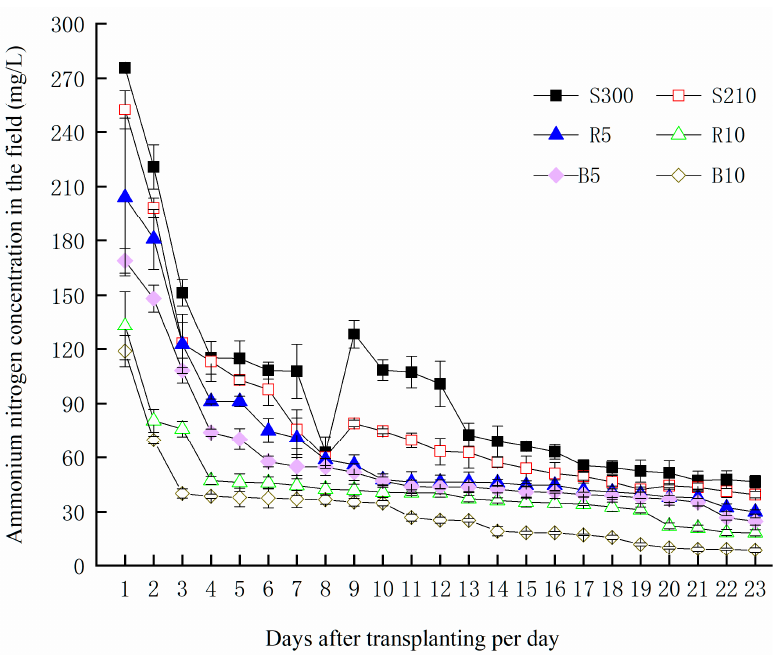
Figure 6. Daily variation of ammonium nitrogen concentration in surface water under different fertilization treatments.